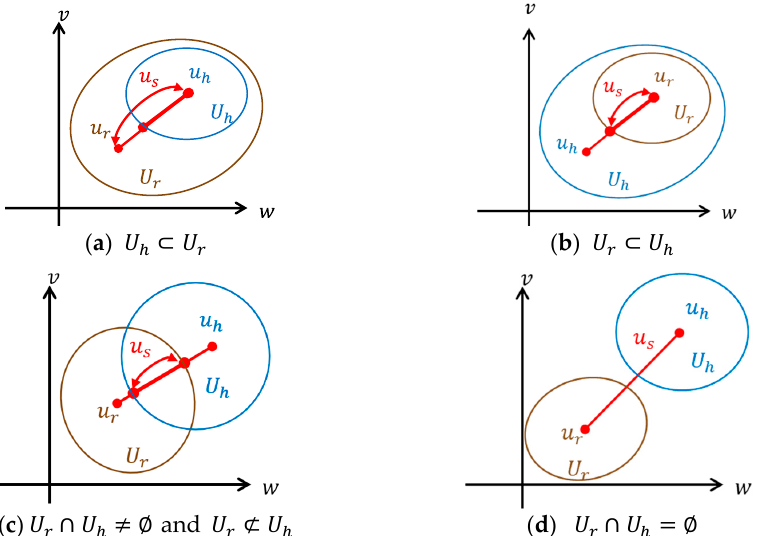
Figure 5. Illustration of the convex set stability analysis for wheelchair motion controlling between the robot and human user.